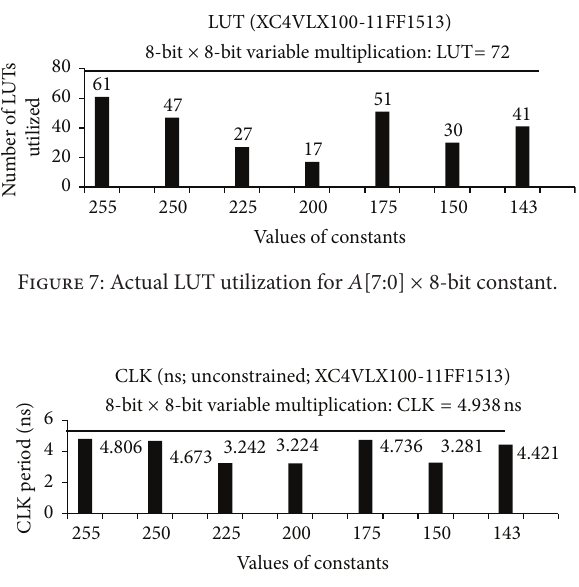
Figure 8: CLK period (ns) for 𝐴 [7:0] × 8-bit constant.